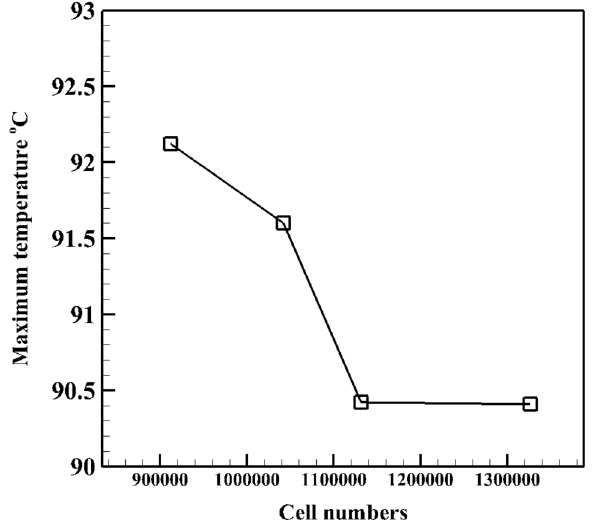
Fig. 9 Grid study for second step of simulation